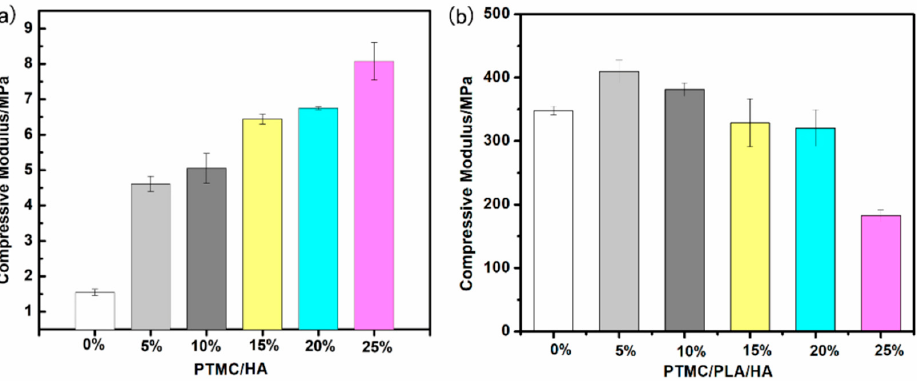
Figure 4. Compressive modulus of PTMC/HA ( a ) and PTMC/PLA/HA ( b ) scaffolds.